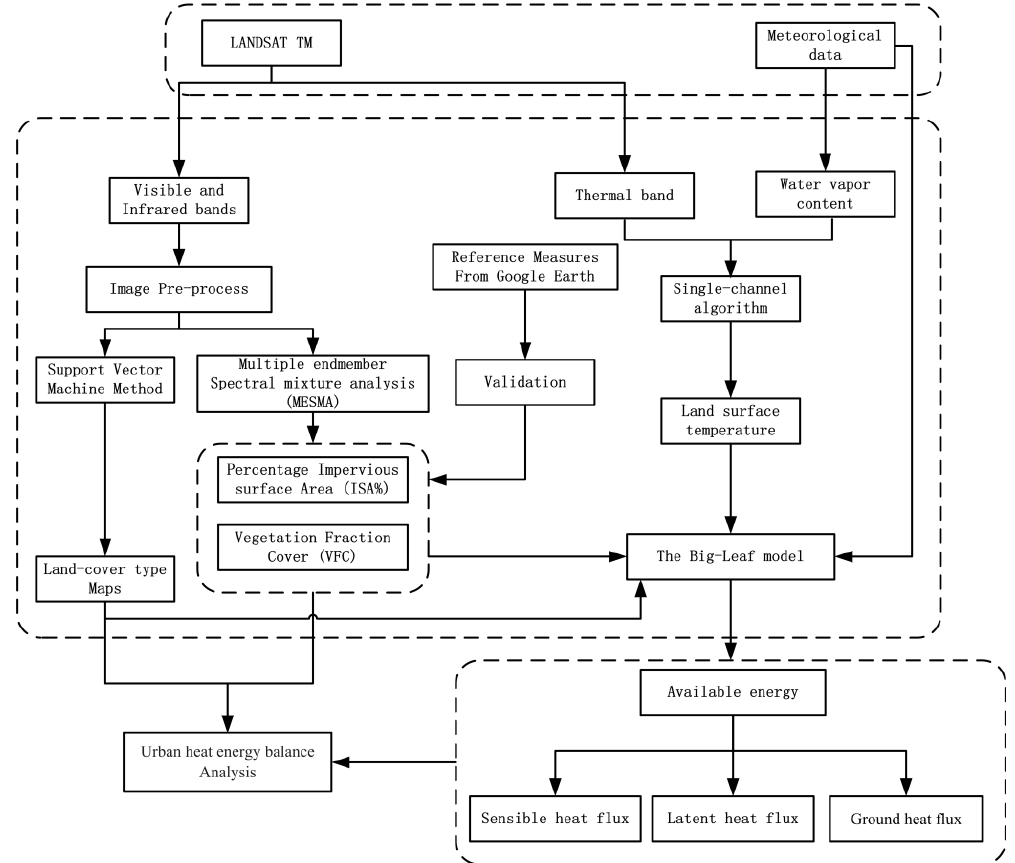
Figure 2. The overall flowchart of this research; the dashed boxes from top to bottom represent the section of input data, data processing and output data, respectively.